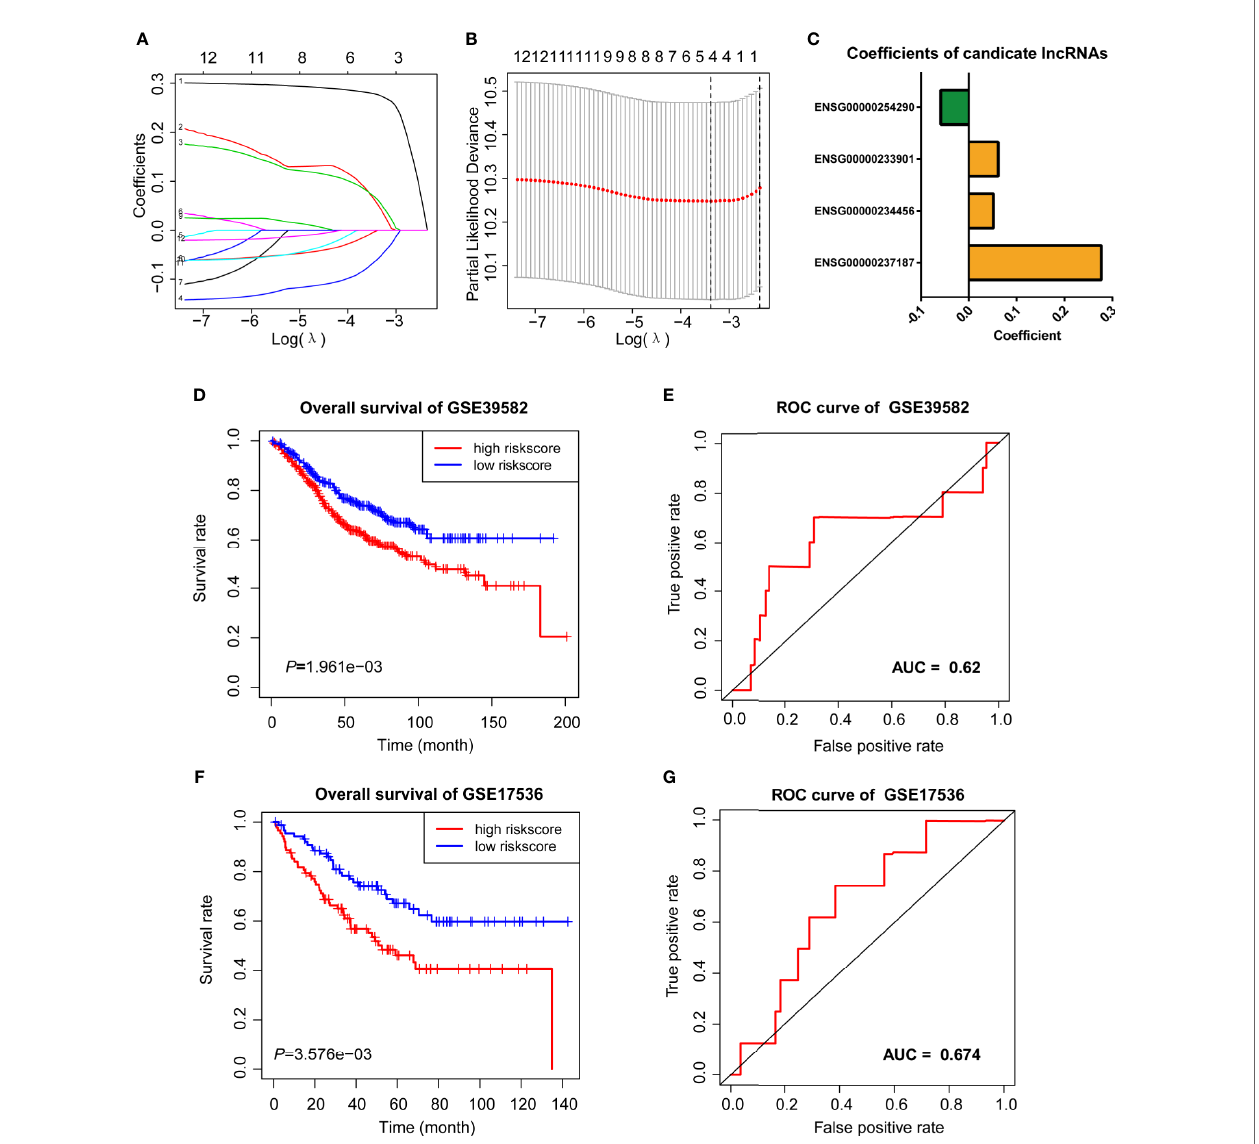
FIGURE 3 | LASSO cox analysis and survival analysis of m6A-TME-LM. (A – C) LASSO regression was performed, calculating the minimum criteria (A, B) and coef fi cients (C) . (D) Kaplan – Meier curves showed that the high-risk subgroup had worse overall survival than the low-risk subgroup in GSE39582 data set. (E) Receiver operating characteristic (ROC) curves of m6A-TME-LM for predicting the overall survival in GSE39582 data set. (F) Kaplan – Meier curves showing that the high-risk subgroup had worse overall survival than the low-risk subgroup in GSE17536 data set. (G) Receiver operating characteristic (ROC) curves of m6A- TME-LM for predicting the overall survival in GSE17536 data